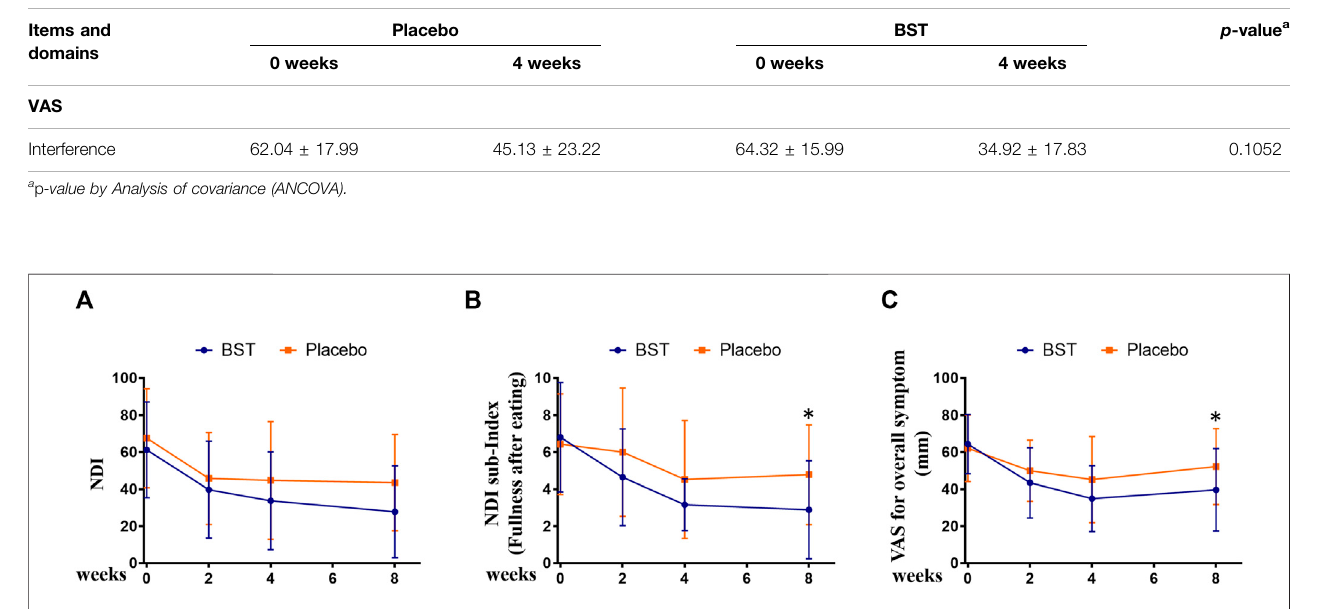
FIGURE 3 | Changes in outcomes between Banha-sasim-tang (BST) and placebo group during the trial. (A) Changes in the Nepean Dyspepsia Index (NDI) symptom score. (B) Changes in the sub-index of NDI symptom score. (C) Changes in the visual analog scale (VAS) for overall symptoms. * p < 0.05 vs placebo group.